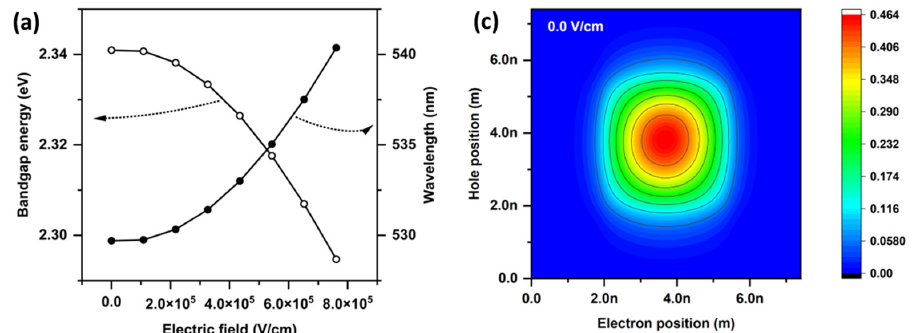
Figure 3. Cont Figure 3. ( a ) Bandgap energy and wavelength as a function of the external electric-field intensity, ( b ) probability densities as a function of the one-dimensional electron–hole distance, and ground state wavefunction distributions as a function of electron and hole positions ( c ) without and ( d ) with external electric field. The legend shows the external electric-field intensity values.